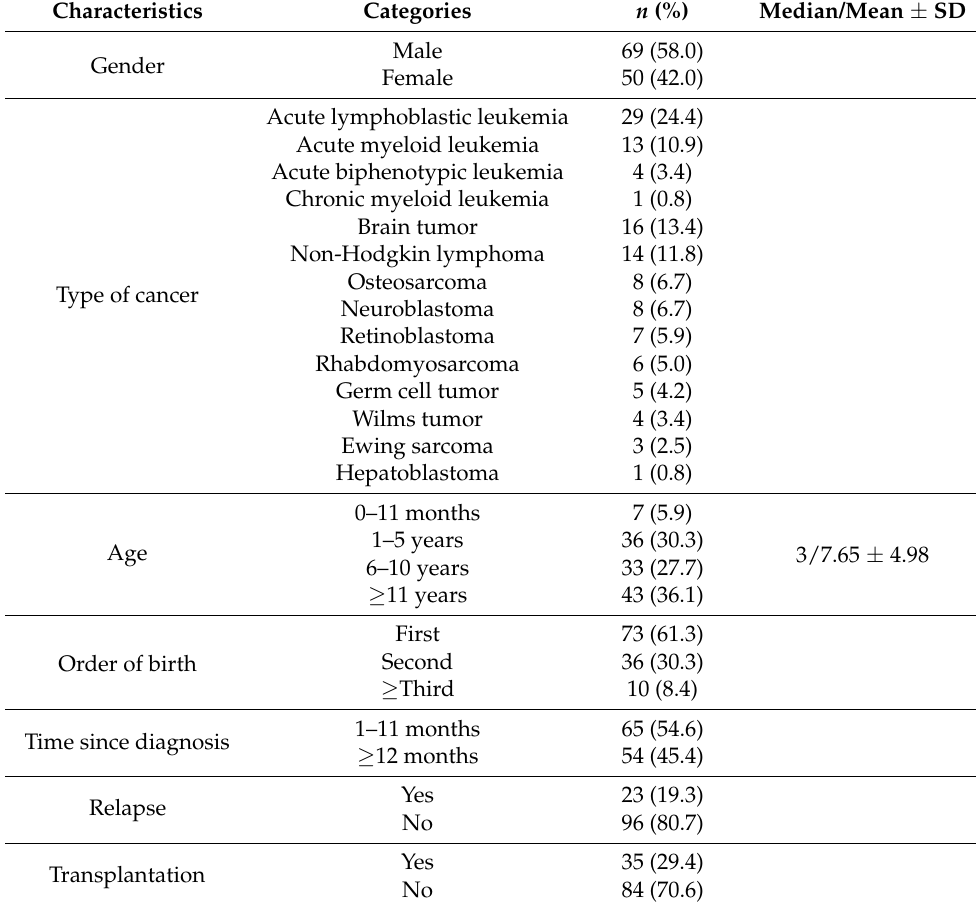
Table 2. Characteristics of Children with Pediatric Cancer ( n =